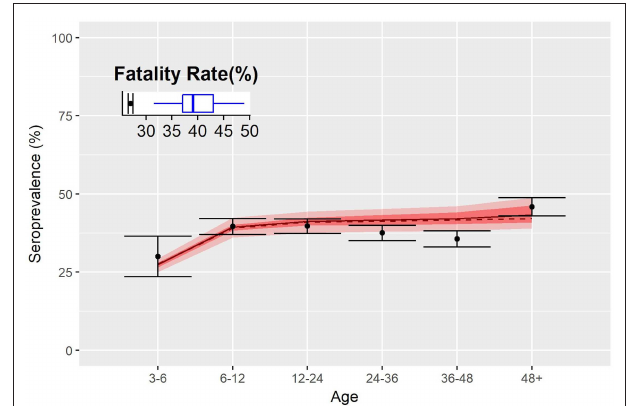
FIGURE 4 | Fatality rates and seroprevalence estimated over the calibration of the transmission model. Dots represent the percentage of seropositive by age group, and shaded red area indicates 50 and 95% confidence interval of simulations. Inset shows the fatality rate estimate of the disease as from data (dots) and model (blue